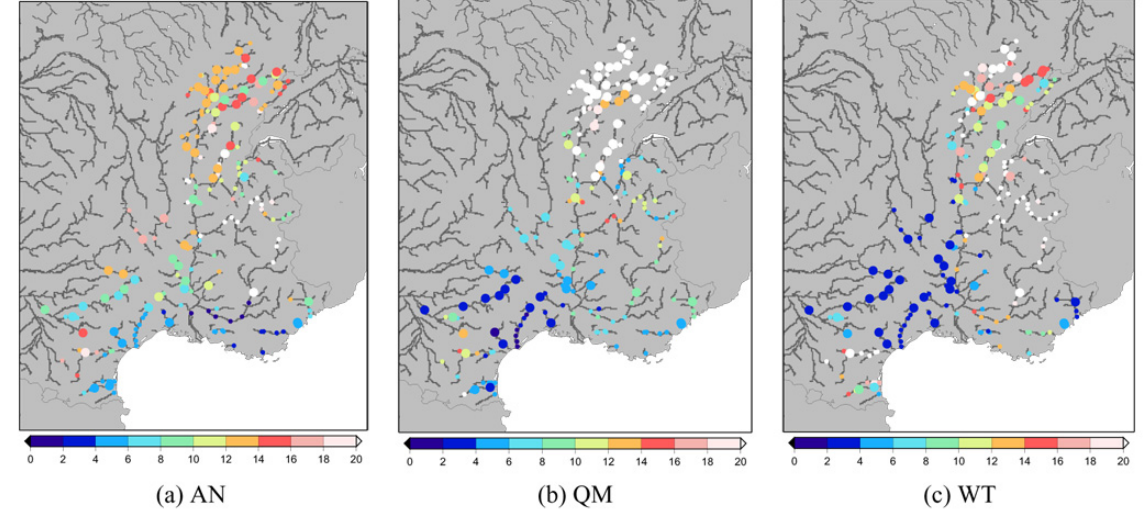
Fig. 13. Return period in years, calculated for 2035–2064, of the discharge corresponding to the QJXA10 of 1970–1999. Values smaller than 10 indicate a decrease of the return period.